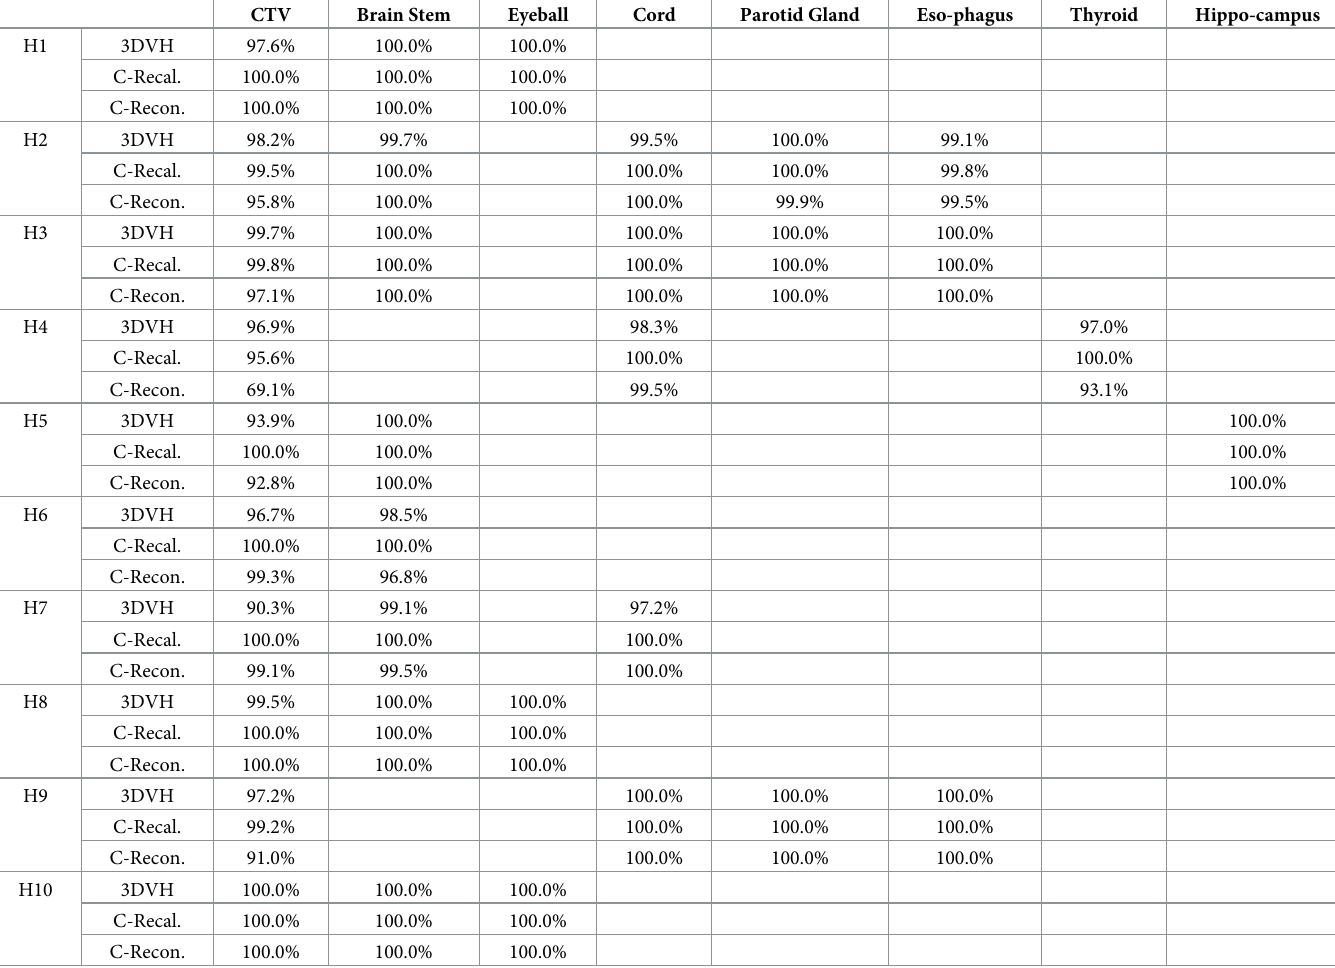
Table 3. Pass rates calculated for the gamma evaluation in the tumor target and OARs compared with a reference TPS dose with the calculated dose in 3DVH and compass (C-Recal.: Compass Recalculation, C-Recon.: Compass Reconstruction) for the Head-Neck